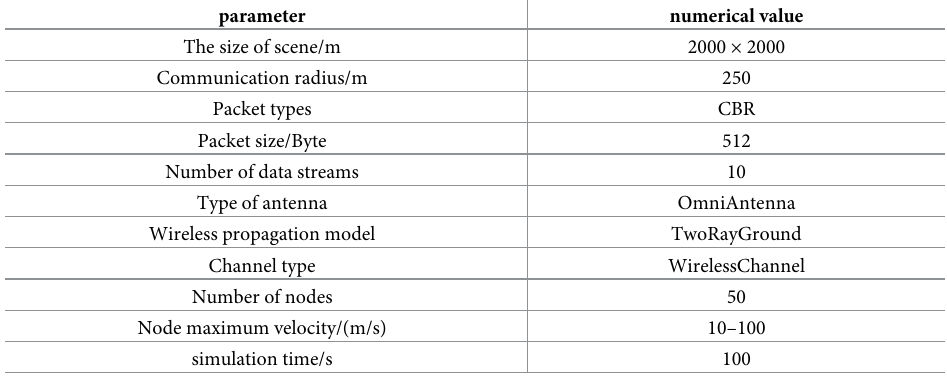
Table 2. Simulation environment parameters